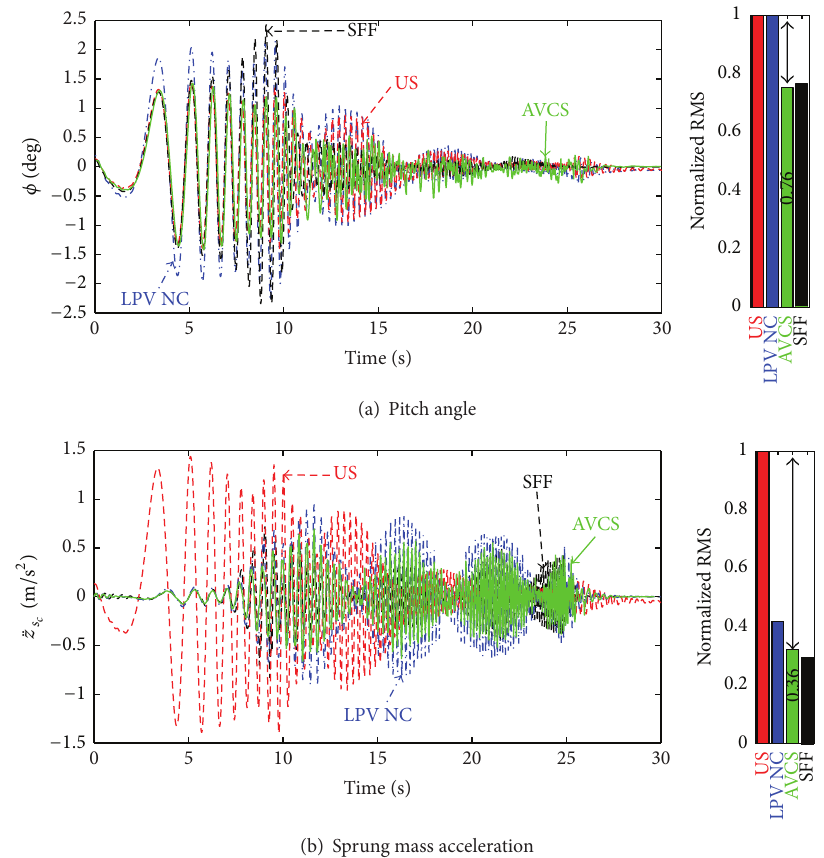
Figure 12: Performance of the AVCS and comparison with other suspension systems in test # 2 , by using a normalized RMS with respect to the uncontrolled suspension.